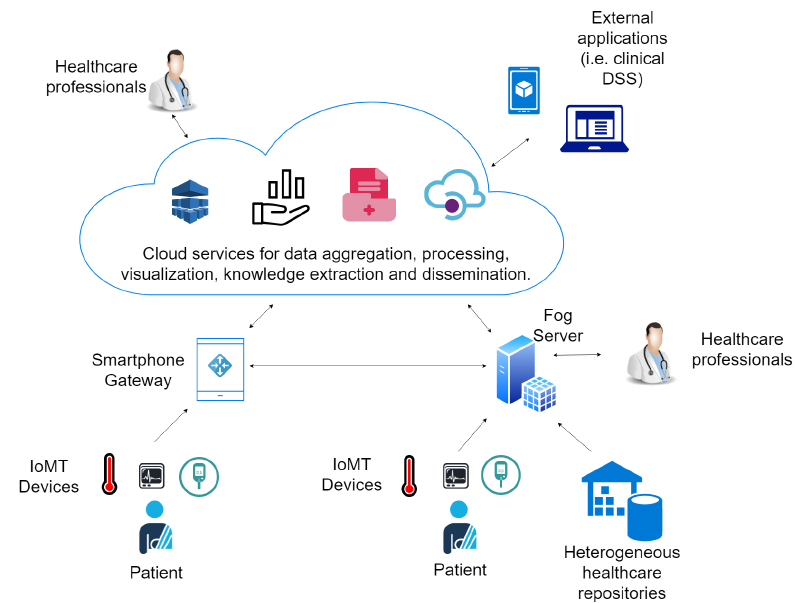
Figure 3. Typical IoMT-based e-Health system.